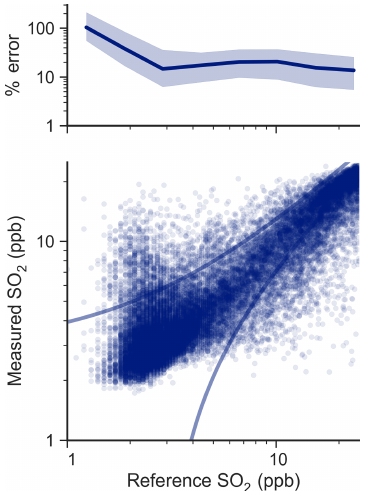
Figure 8. Performance of the sensor (node SO2-02) at lower ( < 25ppb) levels of SO 2 , evaluated using k NN regression. Data shown are from the validation dataset and result in an r 2 = 0 . 788 with RMSE = 2 . 9ppb. The top plot shows the relative error as a percent- age of concentration where the dark line is the median value and the shaded region is the interquartile range. Other sensors evaluated at 0–25ppb showed even better performance (median r 2 : 0.864; me- dian RMSE: 2.1ppb); results are given in Table